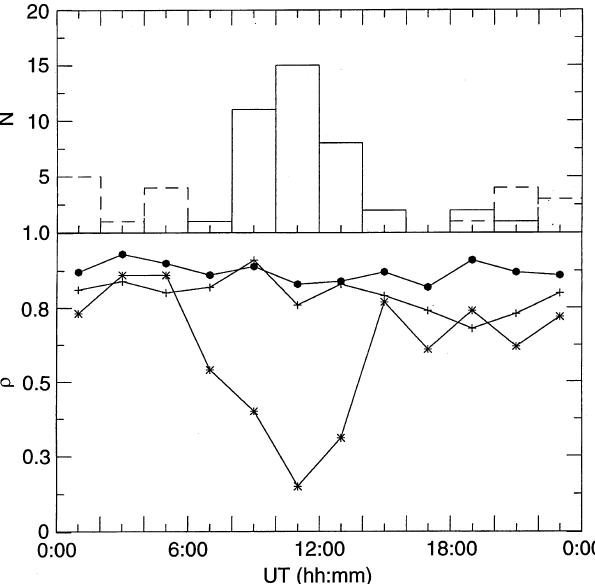
Fig. 3. The upper panel is a histogram of negative AUS-80 numbers ( solid line ) and positive ALS-80 numbers ( dashed line ); the lower panel shows the linear correlations versus UT time ( each point is shown at the centre of time interval) between AES-80 and AE ( d ), ALS-80 and AL (+), AUS-80 and